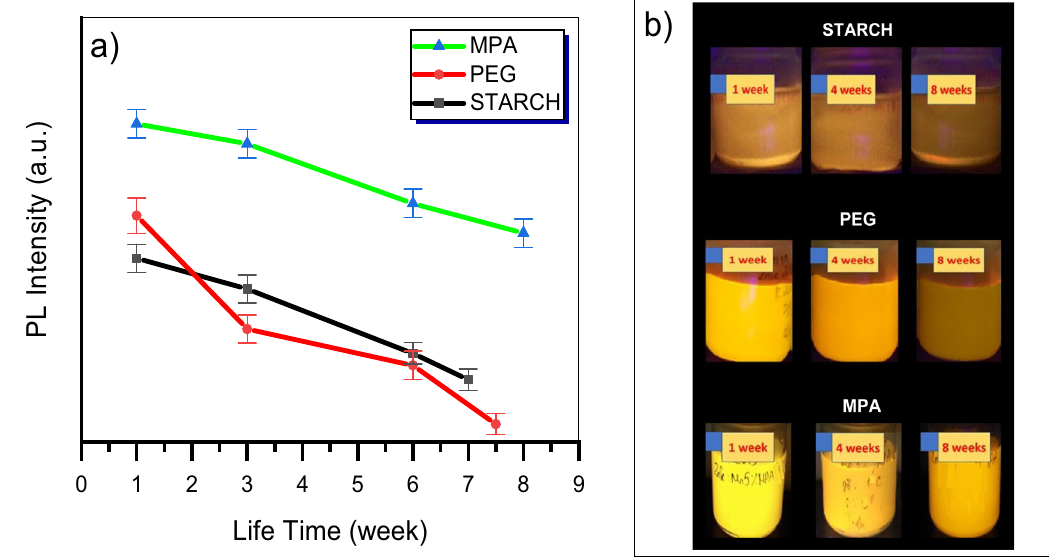
Figure 7: The PL life time of ZnSe:5%Mn capped with MPA, PEG, and